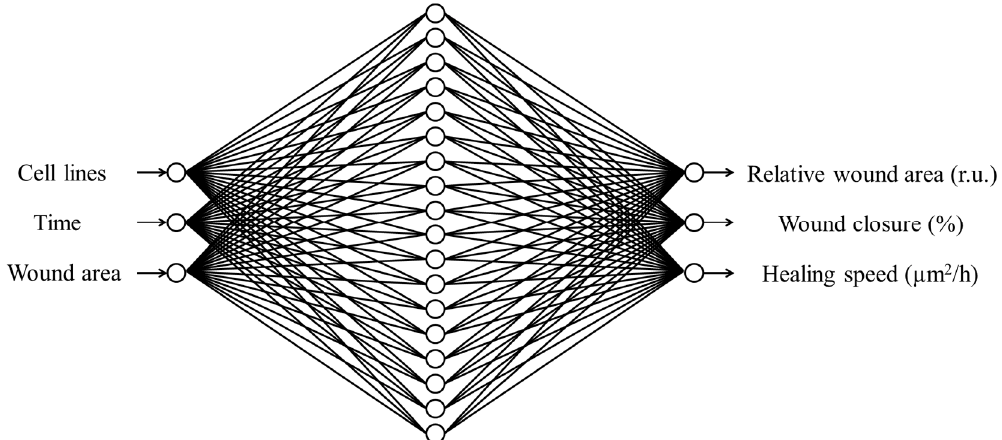
Figure 3. The proposed multilayer feedforward perception (MLP) network consisting of three inputs, one hidden layer with eighteen neurons, and three outputs. r.u.: relative unit, %: percentage; h = hour.